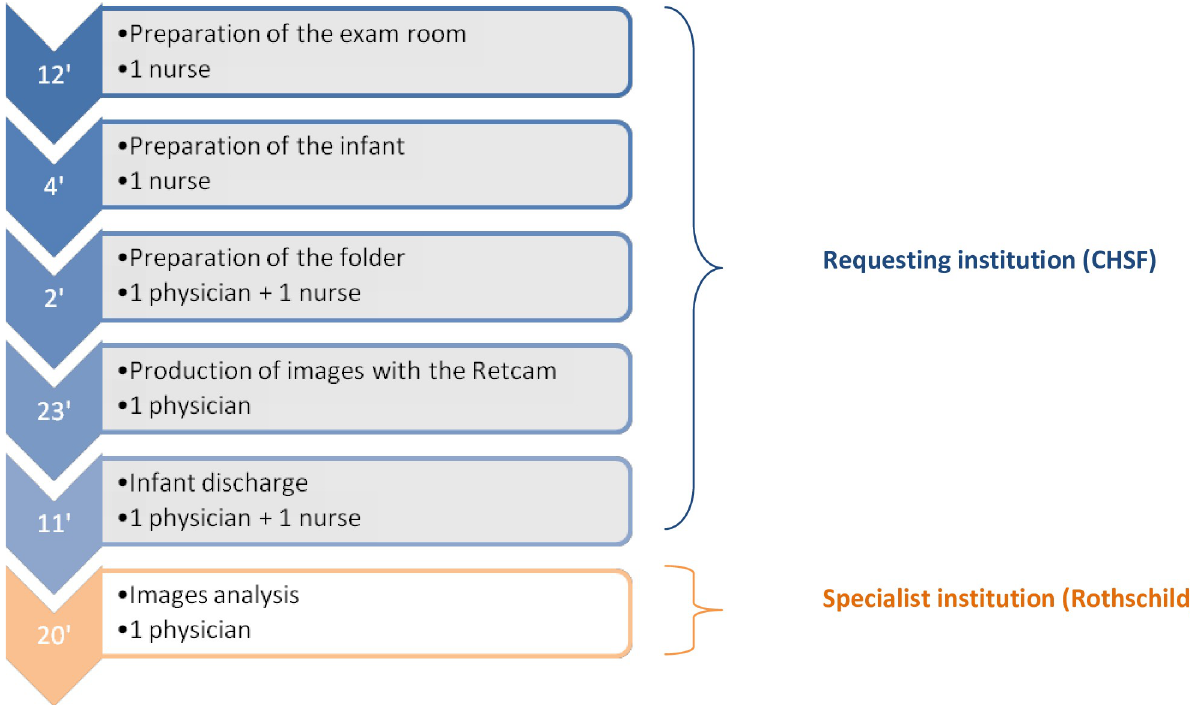
Fig 2. Workflow, tele-expertise